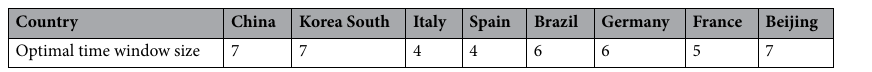
Table 3. The optimal time window size of each country or region in the data